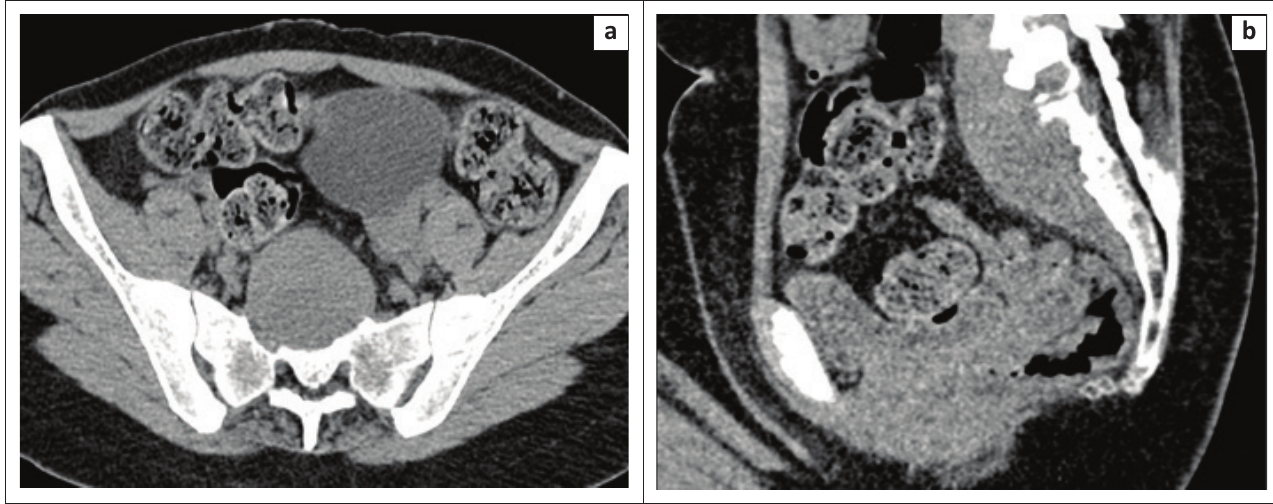
FIGURE 1: (a and b) Axial and sagittal images at the level of sacrum demonstrate an elongated hypodense collection in the high presacral region resulting in erosion of the anterior aspect of the upper sacral vertebrae. The collection was unapproachable anteriorly because of the presence of bladder and bowel loops and is located in close proximity to the rectum